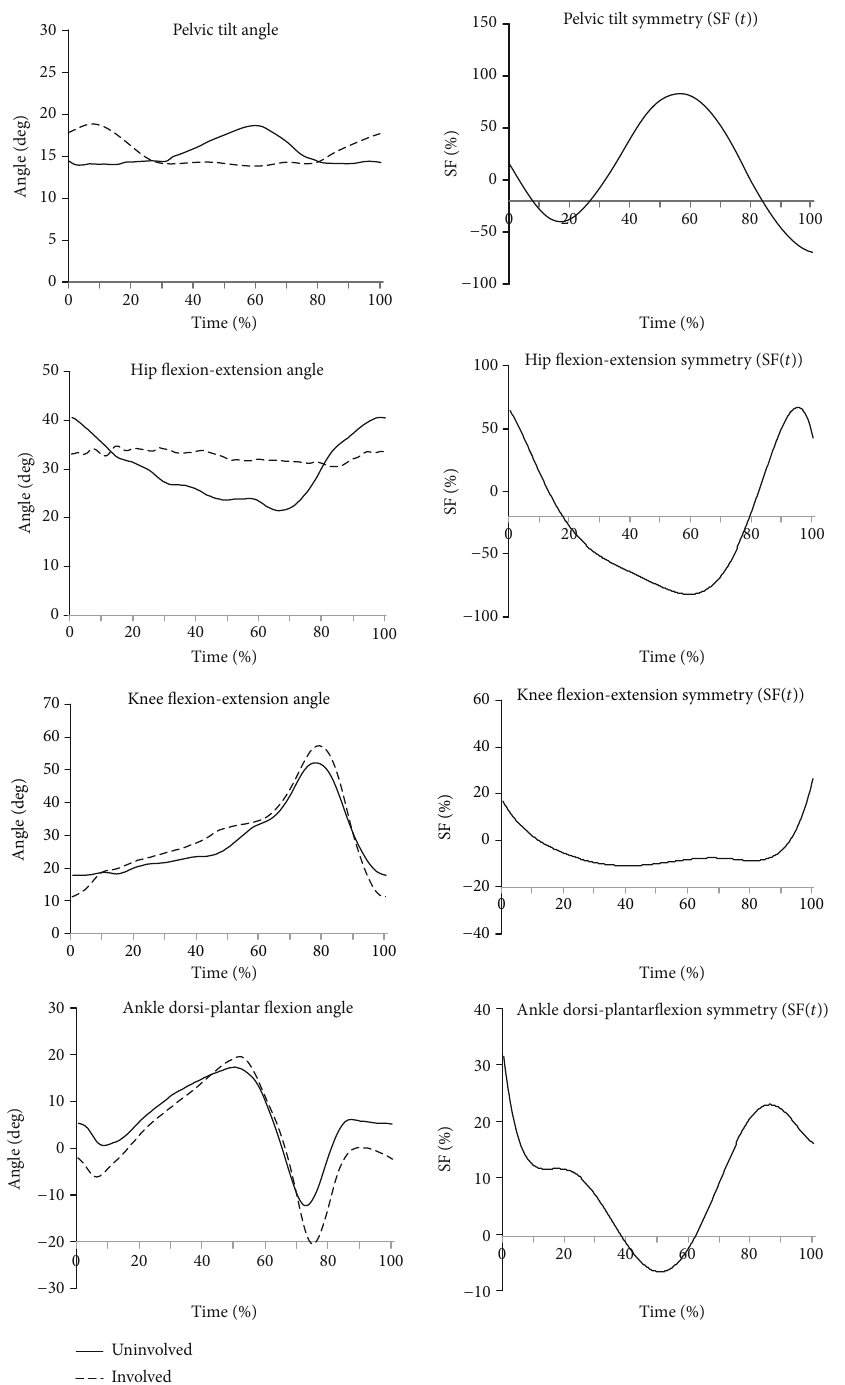
Figure 3: Angular joint kinematics in the sagittal plane and corresponding symmetry function (SF) for the uTHR group. Positive values of SF indicate uninvolved side dominance in asymmetry, while negative values show involved side